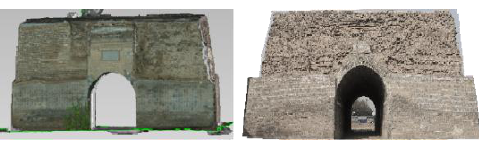
Figure 6. The model is compared with the real ancient city wall 3.3 Measuring the area of the shedding area The original point cloud data were imported into CAD to measure the shedding area and basic data of the four walls of the Drum Tower in Puzhou Old City, as shown in Figure 7. According to the measurement, the falling off area of the east wall is 101.55 m 2 ,The area of wall shedding on the west side is 95.21 m 2 , the area of wall shedding on the south side is 80.23 m 2 , and the area of wall shedding on the north side is 88.60 m 2 . The real data of the measurement provides the analysis of the model measurement results in the later